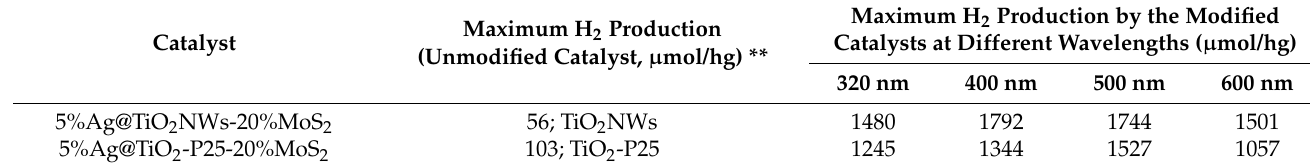
Table 5. Maximum hydrogen production of the unmodified and modified TiO 2 -based catalysts, under irradiation at different wavelengths.